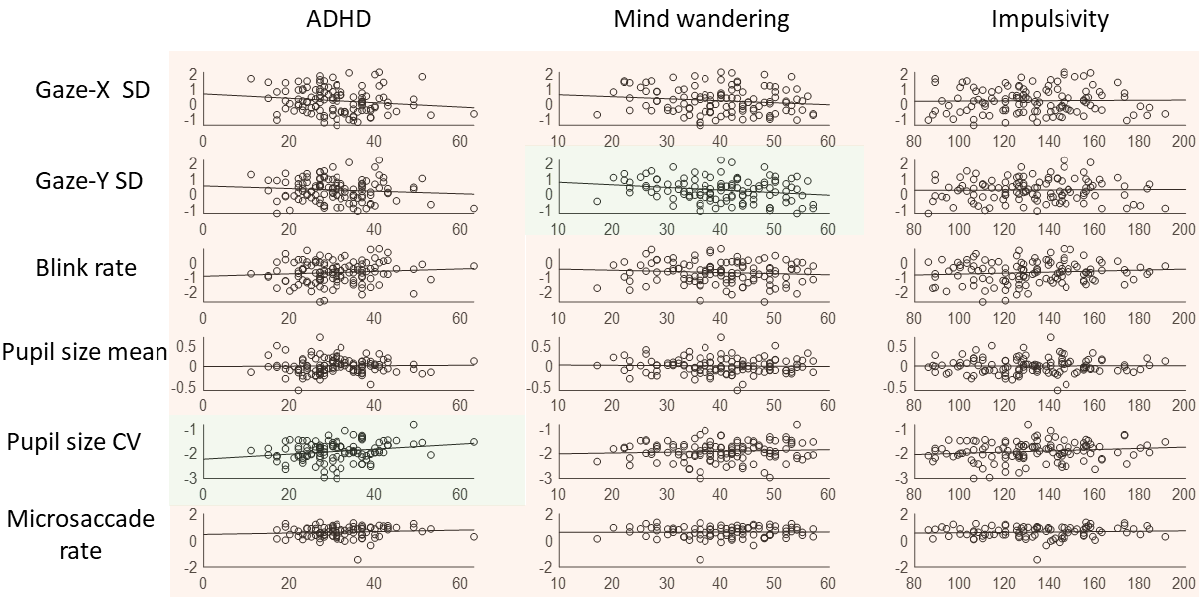
Figure 8. Correlation plots between the oculomotor measures and the questionnaire scores. Green shading indicates that the cor- responding Bayes Factor is above 1 (indicating evidence in favour of a correlation between the conditions on that measure), while red shading indicates a Bayes Factor below 1 (indicating evidence against a correlation). Note that the oculomotor measures are logged.